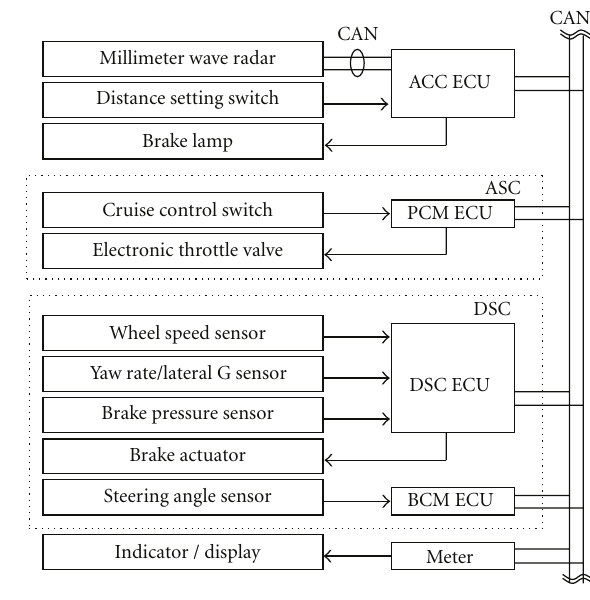
Figure 2: System configuration.